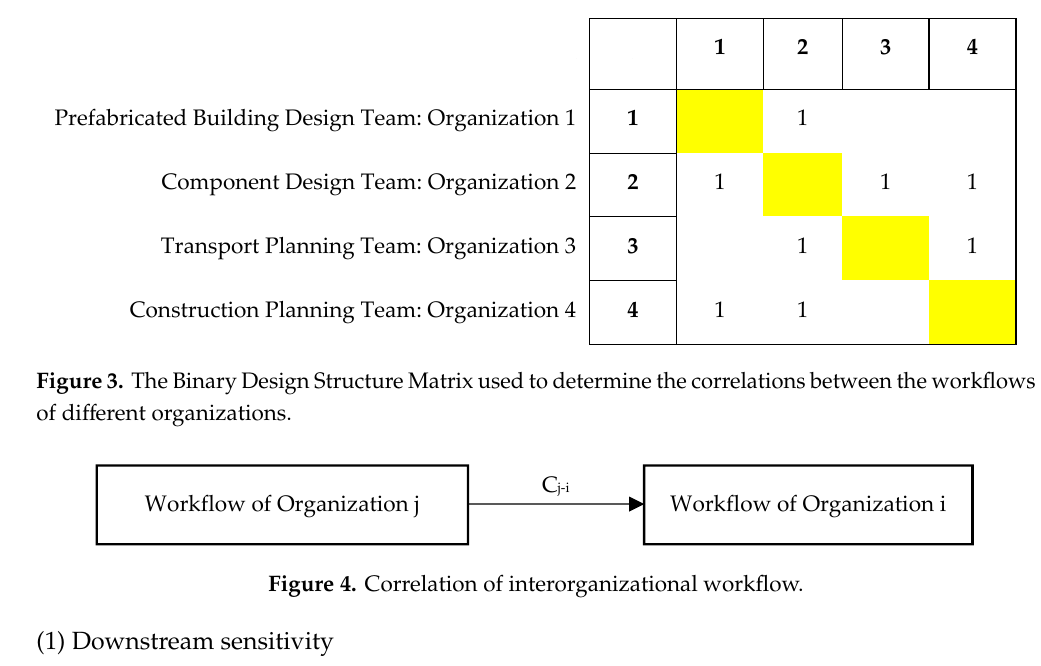
Figure 4. Correlation of interorganizational workflow.